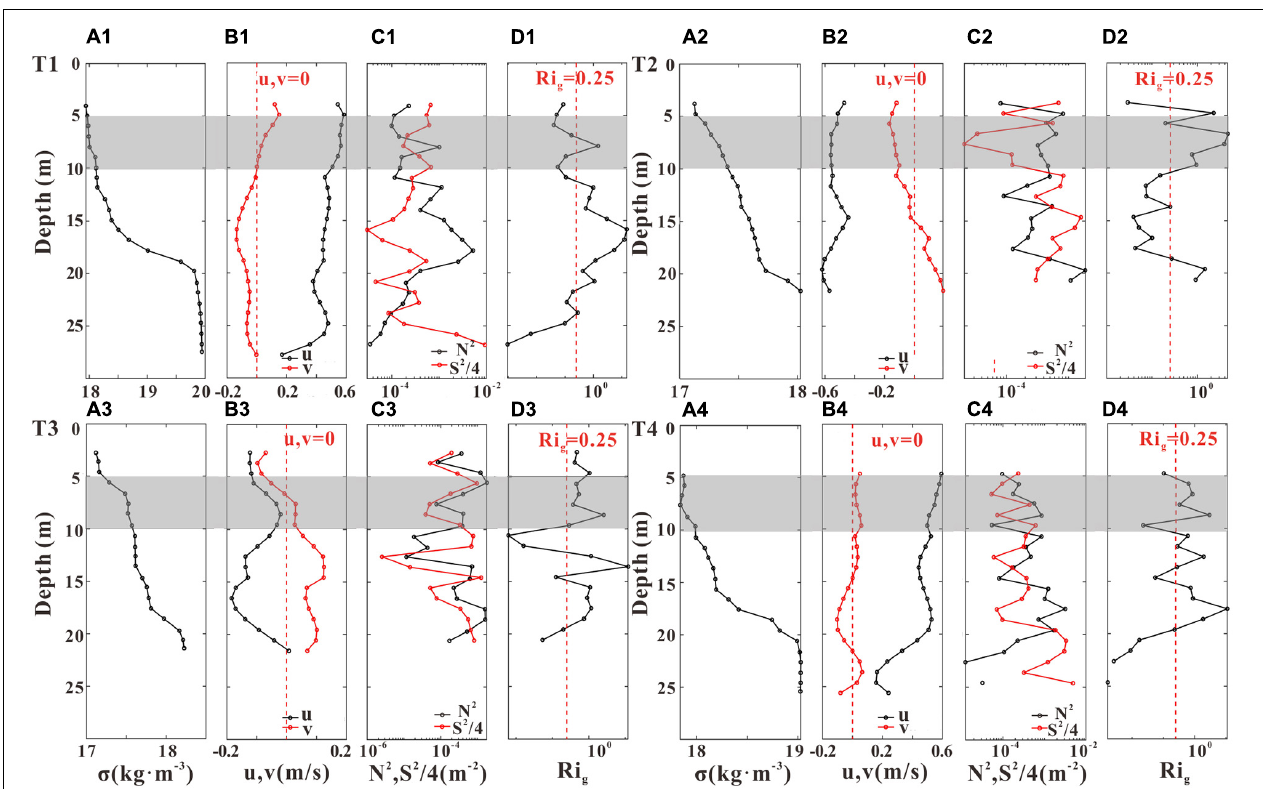
FIGURE 11 | The profiles of density anomaly σ (A1–A4) , u (black line) and v (red line) (B1–B4) , the square of buoyancy frequency N 2 (black line) and the square of velocity shear S 2 /4 (red line) (C1–C4) , and the gradient Richardson number Ri g (D1–D4) during the four representative periods T1–T4 at GJ-02. The red dashed lines indicate u ( v ) = 0 in panels (B1–B4) , and Ri g = 0.25 in panels (D1–D4) , respectively. The shaded parts represent the subsurface (5–10 m)